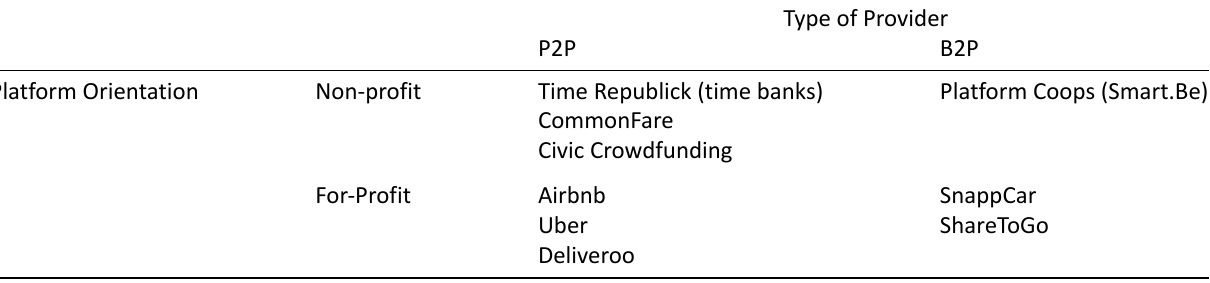
Table 1. Platform orientation and type of provider. Source: Author, after Schor